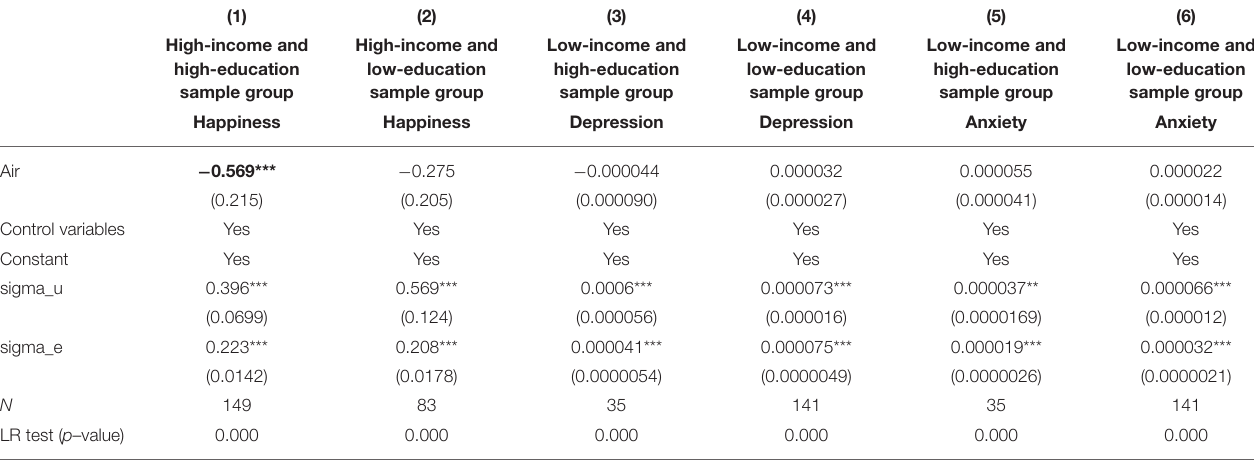
TABLE 10 | Heterogeneity test of education level under different incomes.